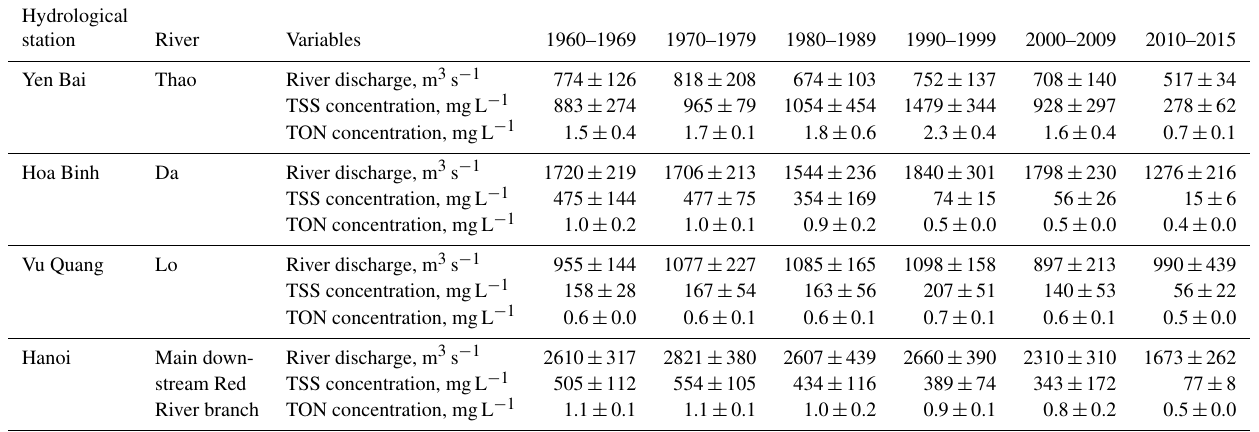
Figure 1. The Red River and its tributaries: location of the large reservoirs and hydrological stations. Table 1. Decade average and standard deviation (SD) of river discharge, TSS and TON concentrations (mgL − 1 ) of the Thao, Da and Lo tributaries and of the main axis of the Red River at Hanoi station in different periods from 1960 to